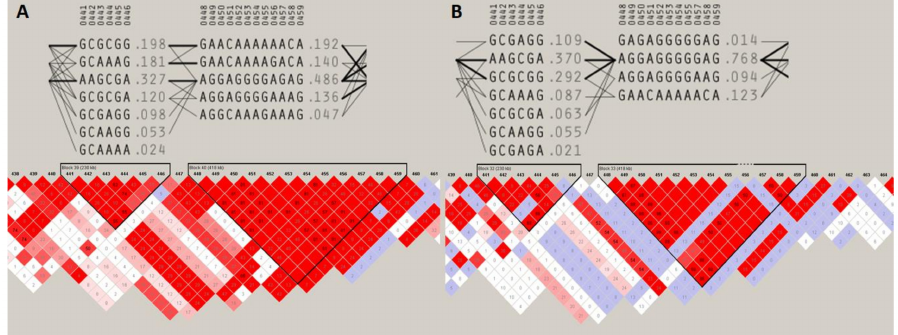
Figure 6. Linkage disequilibrium and haplotype block structure directly at the region divergently selected on ECA3 between Sok ó lski ( A ) and Sztumski ( B ) horses. Successive SNPs on the chromosome are numbered at the top of the figure. Sequences of haplotypes as well as their frequencies are given below. The thickness of lines connecting haplotypes is dependent on the frequency of common segregation, where thick line indicates stronger linkage. Black triangles mark the haplotype blocks. The colored squares represent the pairwise SNPs linkage disequilibrium as D’ values. D’ = 1.00 in the blank red squares. Numbers inside the squares are r 2 × 100. Detailed labeling of LD is described in Haploview manual